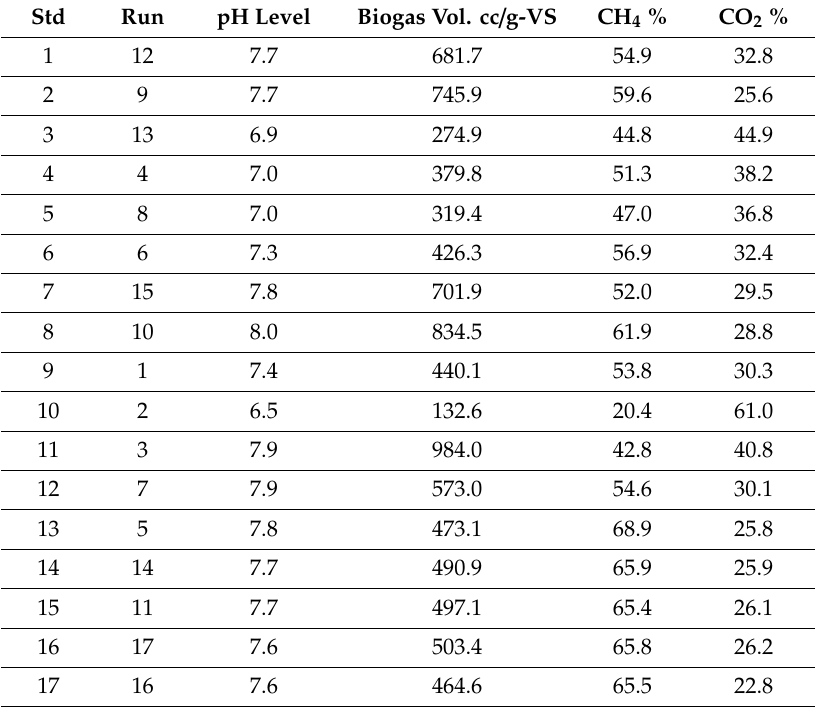
Table 5. A comparison between the results of the controls and the predicted results at the same conditions. Sample